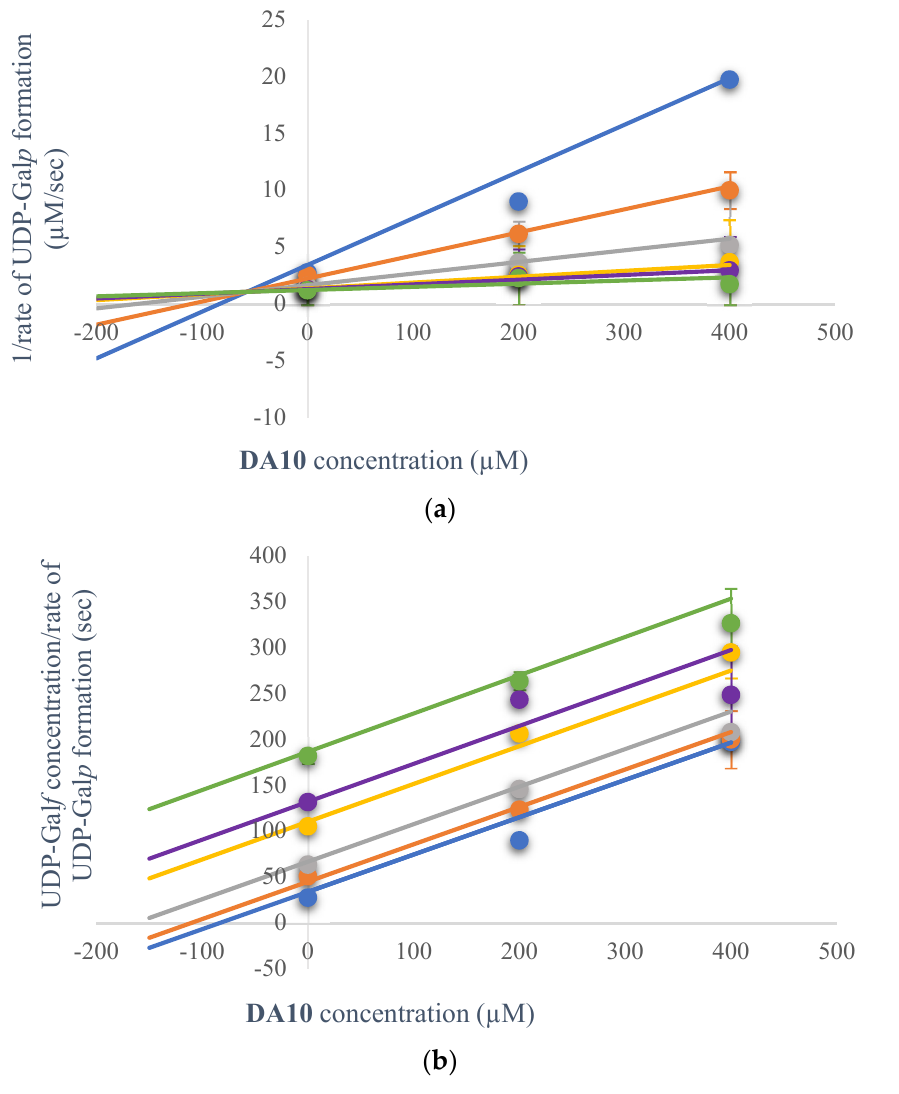
Figure 5. Diagnostic plots areshowing competitive model of inhibition of Mtb UGM by DA10 : ( a ) Dixon plot has crossing lines in the fourth quadrant; ( b ) Cornish-Bowden plot is showing parallel lines.